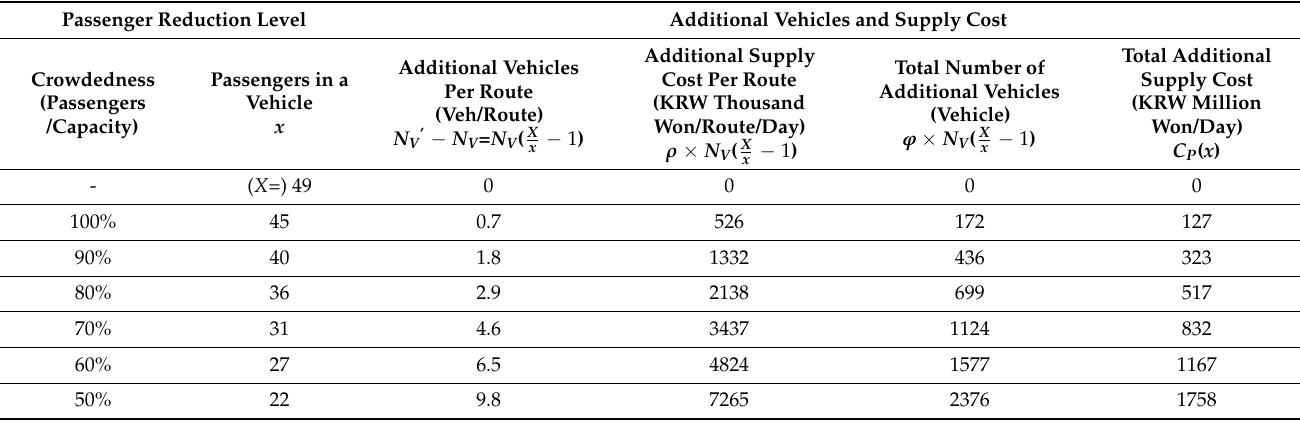
Table 1. Additional supply cost according to the extent of reduction in the number of